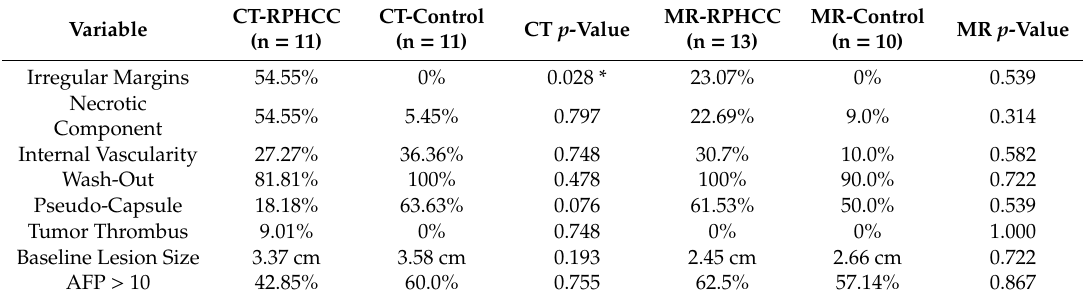
Table 2. Mean analysis of clinical and imaging variables for CT and MR RPHCC and control groups. p -values obtained by the Mann–Whitney U-test, indicating that CT irregular margins are visually di ff erent between the RPHCC and non-RPHCC patients at p = 0.028. * indicates a statistically significant di ff erence in texture analysis feature extraction value between groups using the Mann–Whitney test.